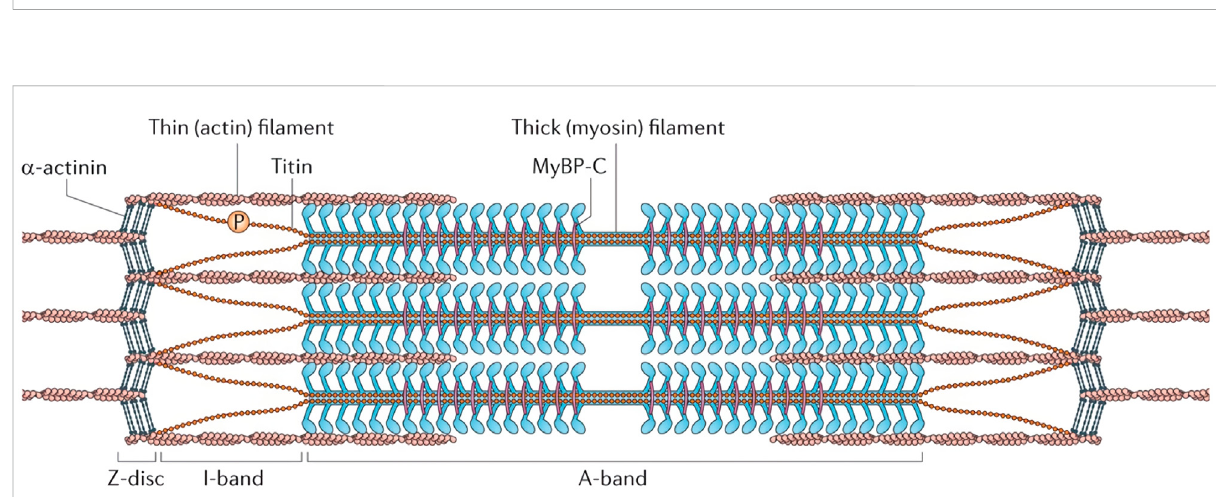
Illustrationofthesarcomerestructure(HwangandSykes,2015).TheI-bandcorrespondstotheregionofF-actinsobservedbymicroscope,and the A-band represents the overlapping area of the myosin thick fi lament and the